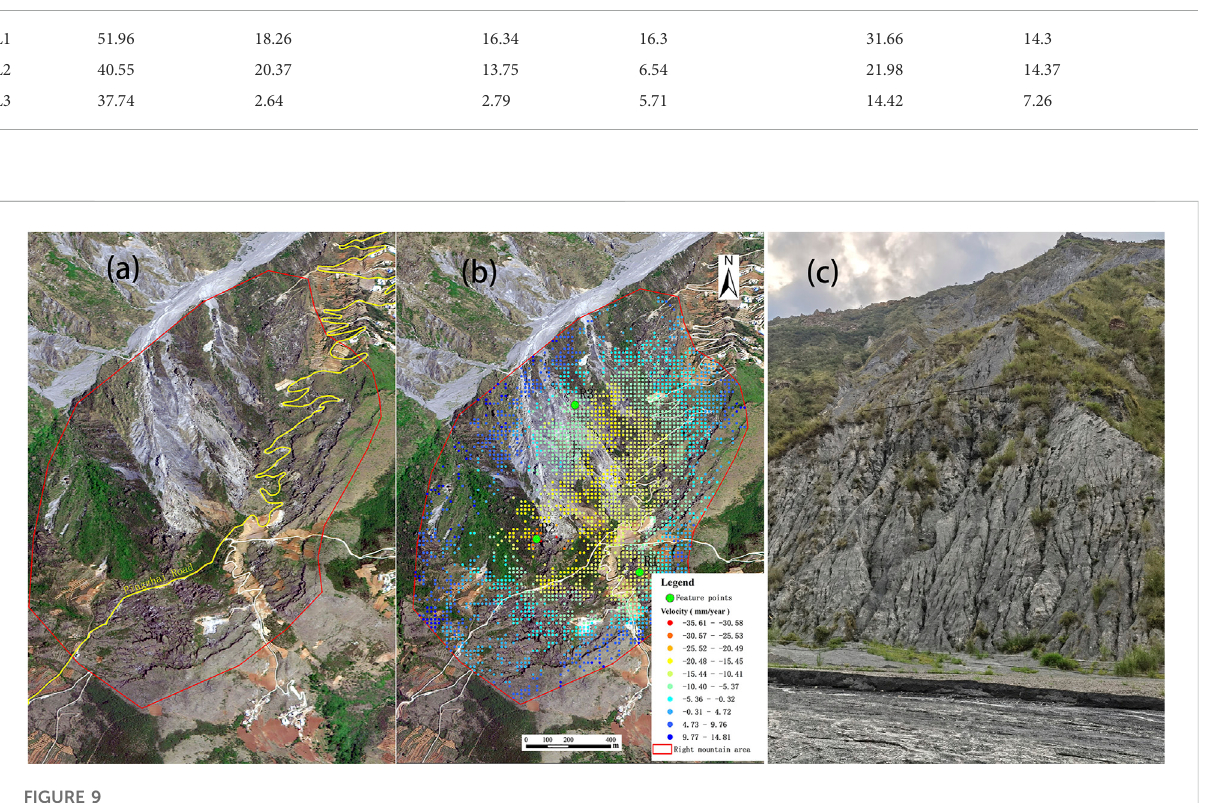
TABLE 3 Annual deformation variable and rainy season deformation variable in the left mountain. Point